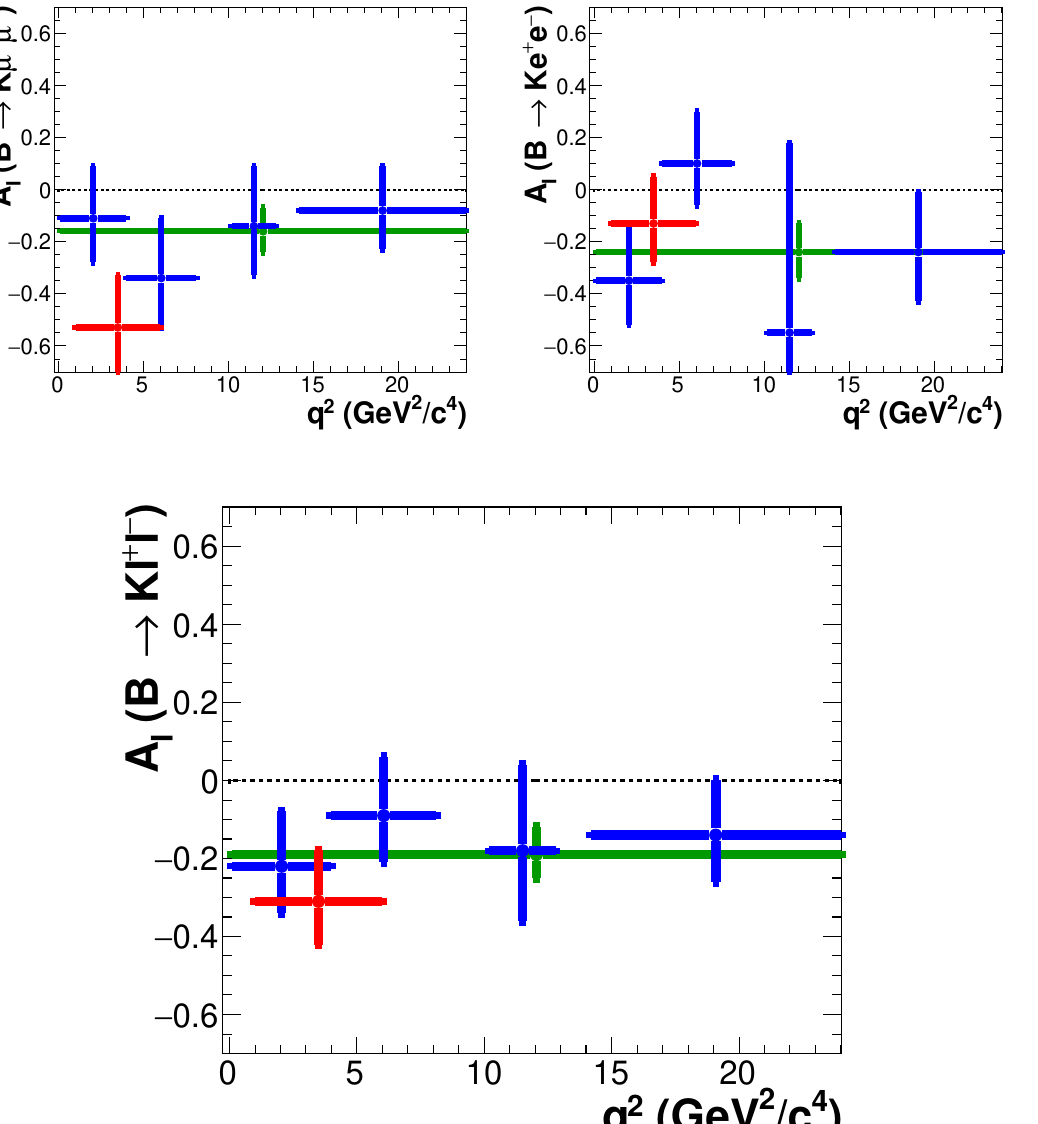
Figure 4 . A I measurements in bins of q 2 , for decays B → Kµ + µ − (top-left), B → Ke + e − (top-right), and both modes combined (bottom). The legends are the same as in figure 3.